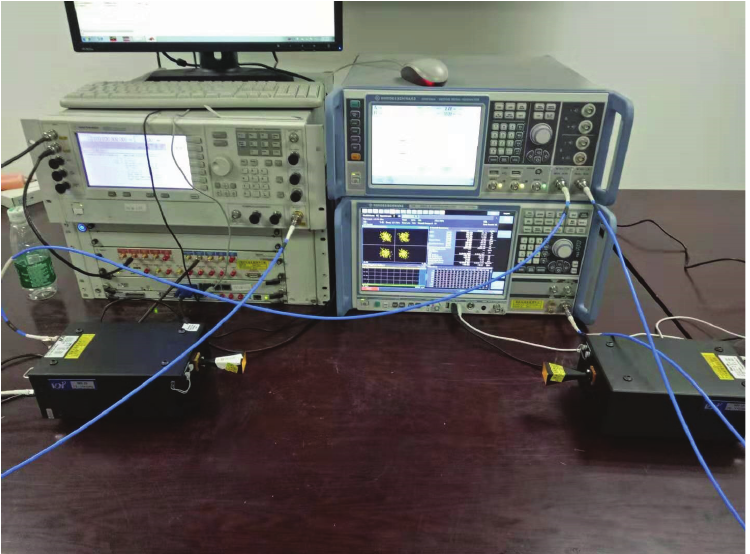
Figure 4. Commercial indoor millimeter wave channel measurement